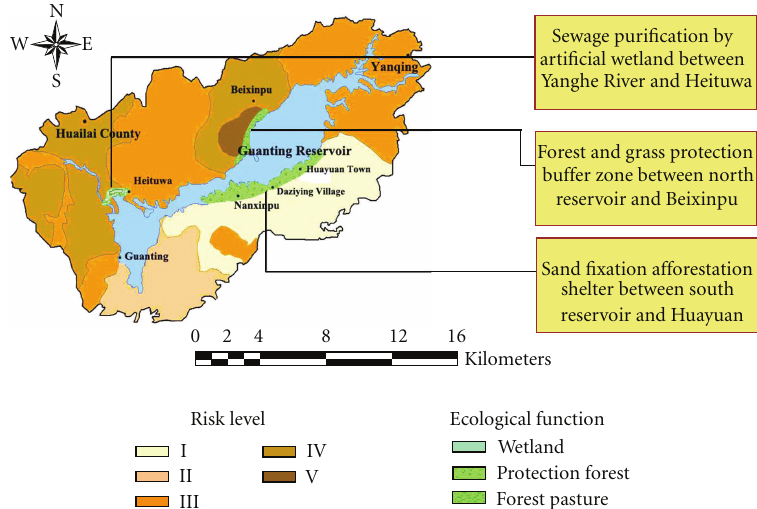
Figure 5: Ecological engineering projects around the Guanting